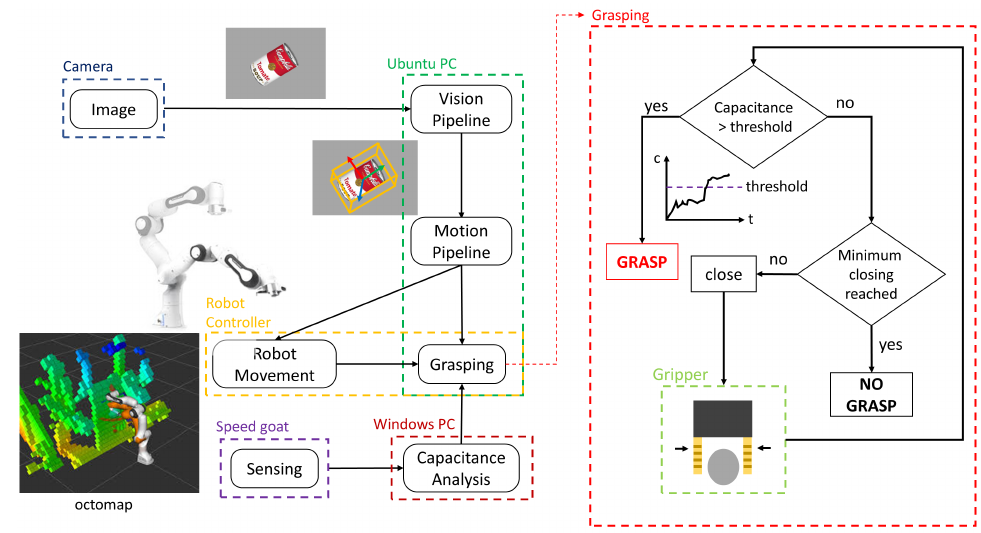
Figure 8. Schematic describing the complete pipeline with the connections among the